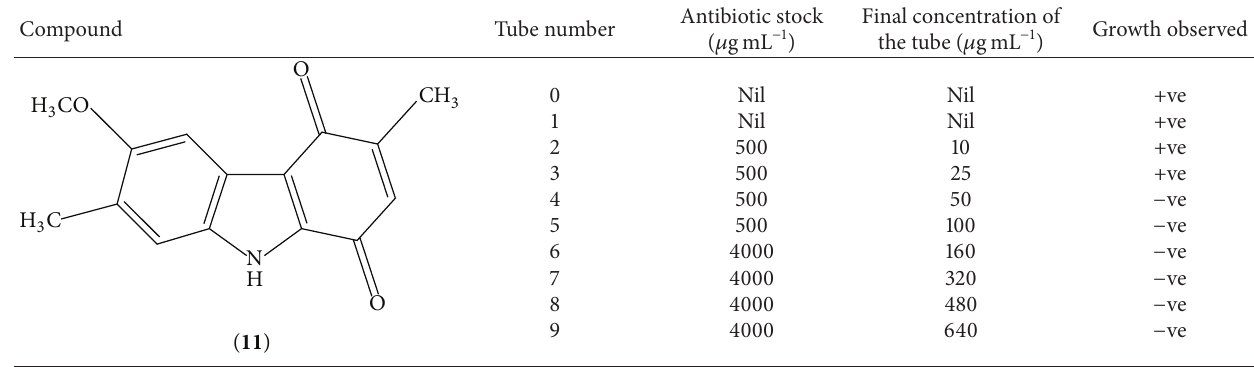
Table 4: Result of MIC determination of compound 11